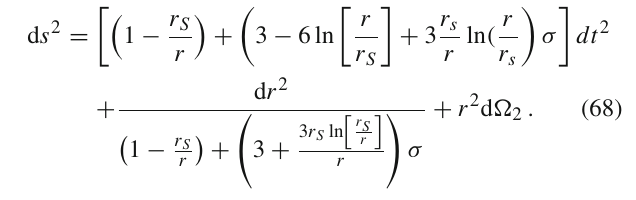
Fig. 8 Trajectories of particles with angular momentum L = 4 in the background of DST black hole with r S = 2 and σ = 0 . 003. Left panel: for bounded orbits like planetary orbit with energy E 2 = 0 . 91. Right panel: for the scattering of neutral particles with different values